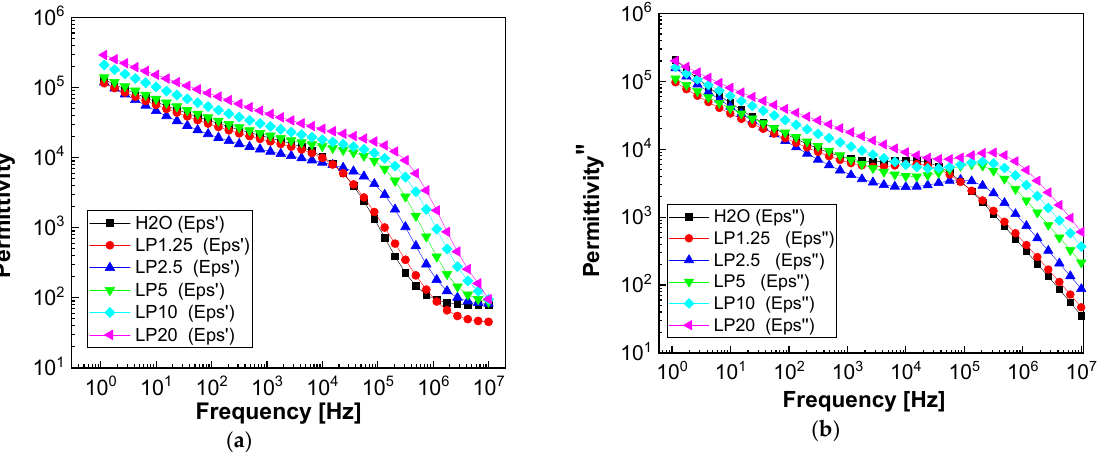
Figure 10. The dependence of the dielectric constant ( a ) and dielectric loss ( b ) with the frequency, in the range of the LF, when the concentration of the LP ( 1 ) solution varies from 0 (black curve) to 0.125 mg/mL (red curve), 0.25 mg/mL (blue curve), 0.5 mg/mL (green curve), 1 mg/mL (cyan curve) and 2 mg/mL (magenta curve).